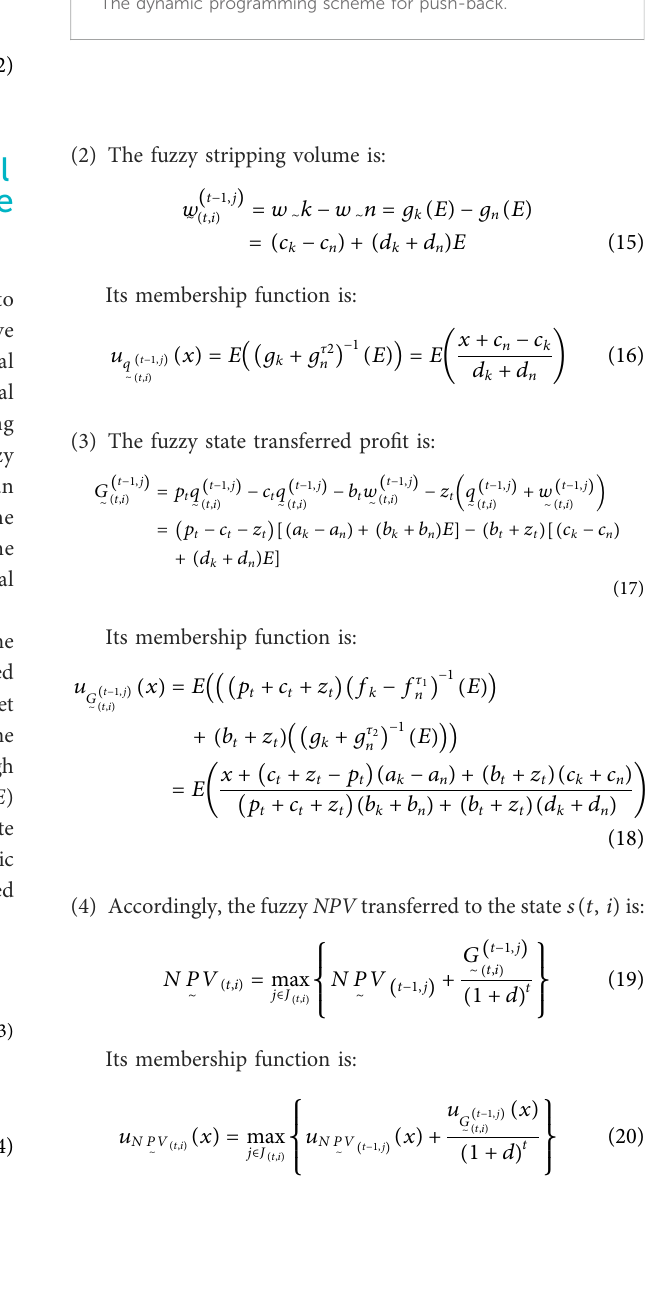
FIGURE 3 The dynamic programming scheme for